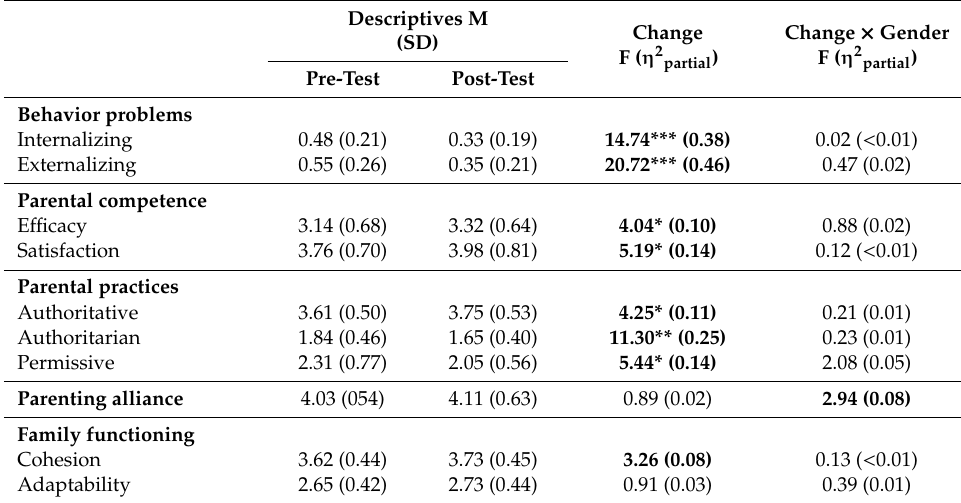
Table 2. Descriptives and inferential statistics for change and change * gender interaction of the mixed factorial ANOVAs for each dependent variable.